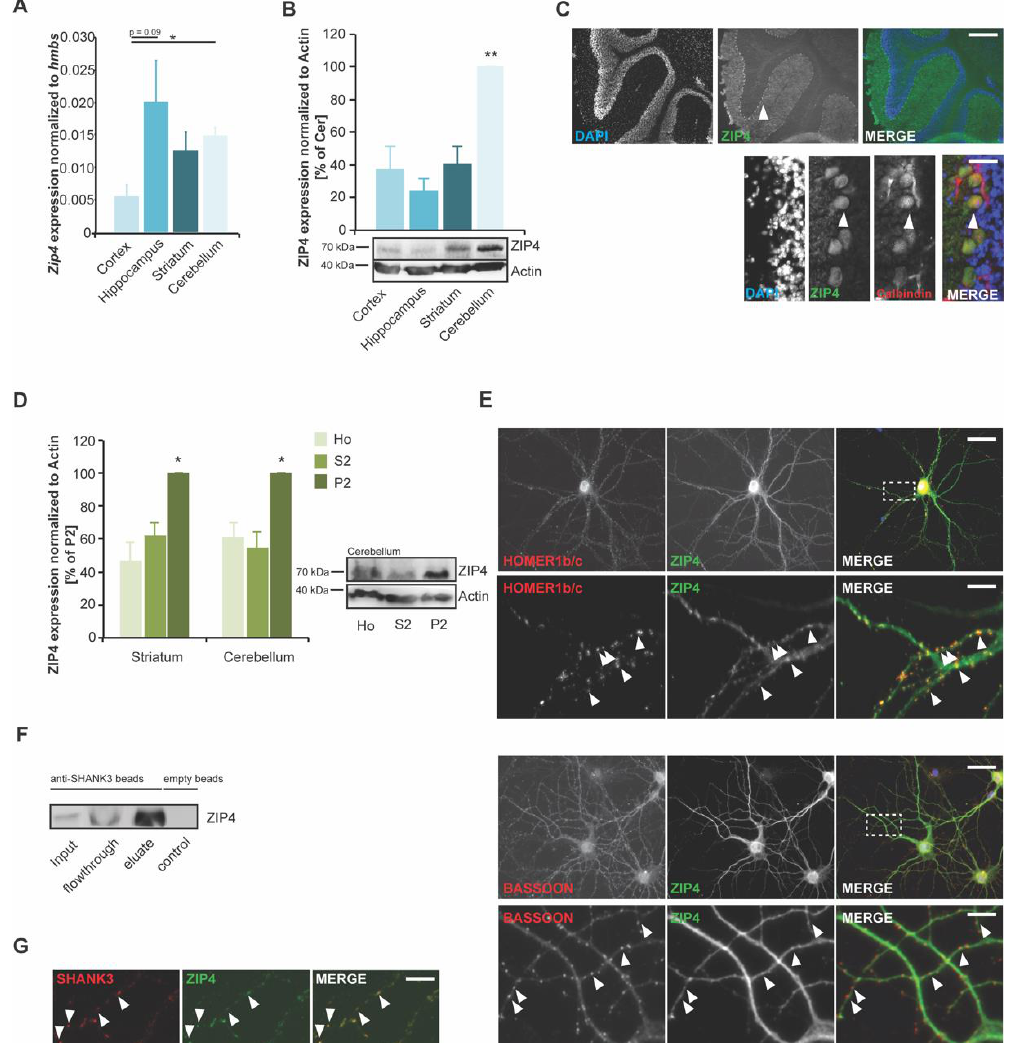
Figure 2. Zip4 is expressed at synapses in neurons and enriched in Purkinje cells of the cerebellum. ( A ) Expression of the Zip4 gene was detected in brain lysate of wild-type mice ( n = 3 animals) and normalized against hmbs . Lowest mRNA levels were detected in cortex and significantly higher levels compared to cortex were found in cerebellum (ANOVA: F = 5.554; p = 0.006; posttest: ctx vs. cer p = 0.0144). ( B ) Expression of ZIP4 protein was similarly found in all analyzed brain regions (ctx, hip, str and cer), with highest levels observed in cerebellum (ANOVA: F = 15.440; p = 0.003; posttest: ctx vs. cer p = 0.017; hip vs. cer p = 0.006; str vs. cer p = 0.013) ( n = 3 animals). ( C ) High ZIP4 expression was detected in Purkinje cells of the cerebellum. Images show representative stainings of mouse brain sections using ZIP4 antibody and calbindin as a marker for Purkinje neurons (arrows) (scale bar = 250 µ m (upper panel) and = 30 µ m (lower panel)). ( D ) ZIP4 expression is highest in the synapse associated protein fraction (P2), but ZIP4 is also found in the fraction containing soluble cytoplasmic proteins (cerebellum: ANOVA: F = 9.737, p = 0.0049, posttest: Ho vs. P2 p = 0.0354, S2 vs. P2 p = 0.0031; Striatum: Ho vs. P2 p = 0.0417, S2 vs. P2 p = 0.0468) ( n = 3 per brain region and fraction). ( E ) Staining of primary hippocampal cultures at DIV14 shows that ZIP4 expression is found in neurons. MAP2 was used to visualize neuronal cells. DAPI was used to visualize cell nuclei. ICC confirms ZIP4 immunoreactive signals at synapses (arrows, zoomed region indicated by rectangle). There, ZIP4 signals colocalize with the postsynaptic marker protein HOMER1b/c (upper panel) but are juxtaposed to signals from the presynaptic marker protein BASSOON (lower panel) (scale bar = 50 µ m (upper panels) and = 10 µ m (lower panels)). ( F ) Co-IP experiments confirm that ZIP4 can be found in a complex centered around the postsynaptic scaffold protein SHANK3. SHANK3 was coupled to magnetic beads via SHANK3 antibody. Brain lysate from mice was used, and ZIP4 signal was detected in the input and in precipitated proteins in the eluate. Empty beads did not precipitate ZIP4. ( G ) Similar to colocalization with HOMER1b/c, ZIP4 signals colocalize with SHANK3 signals in hippocampal neurons in vitro (scale bar = 15 µ